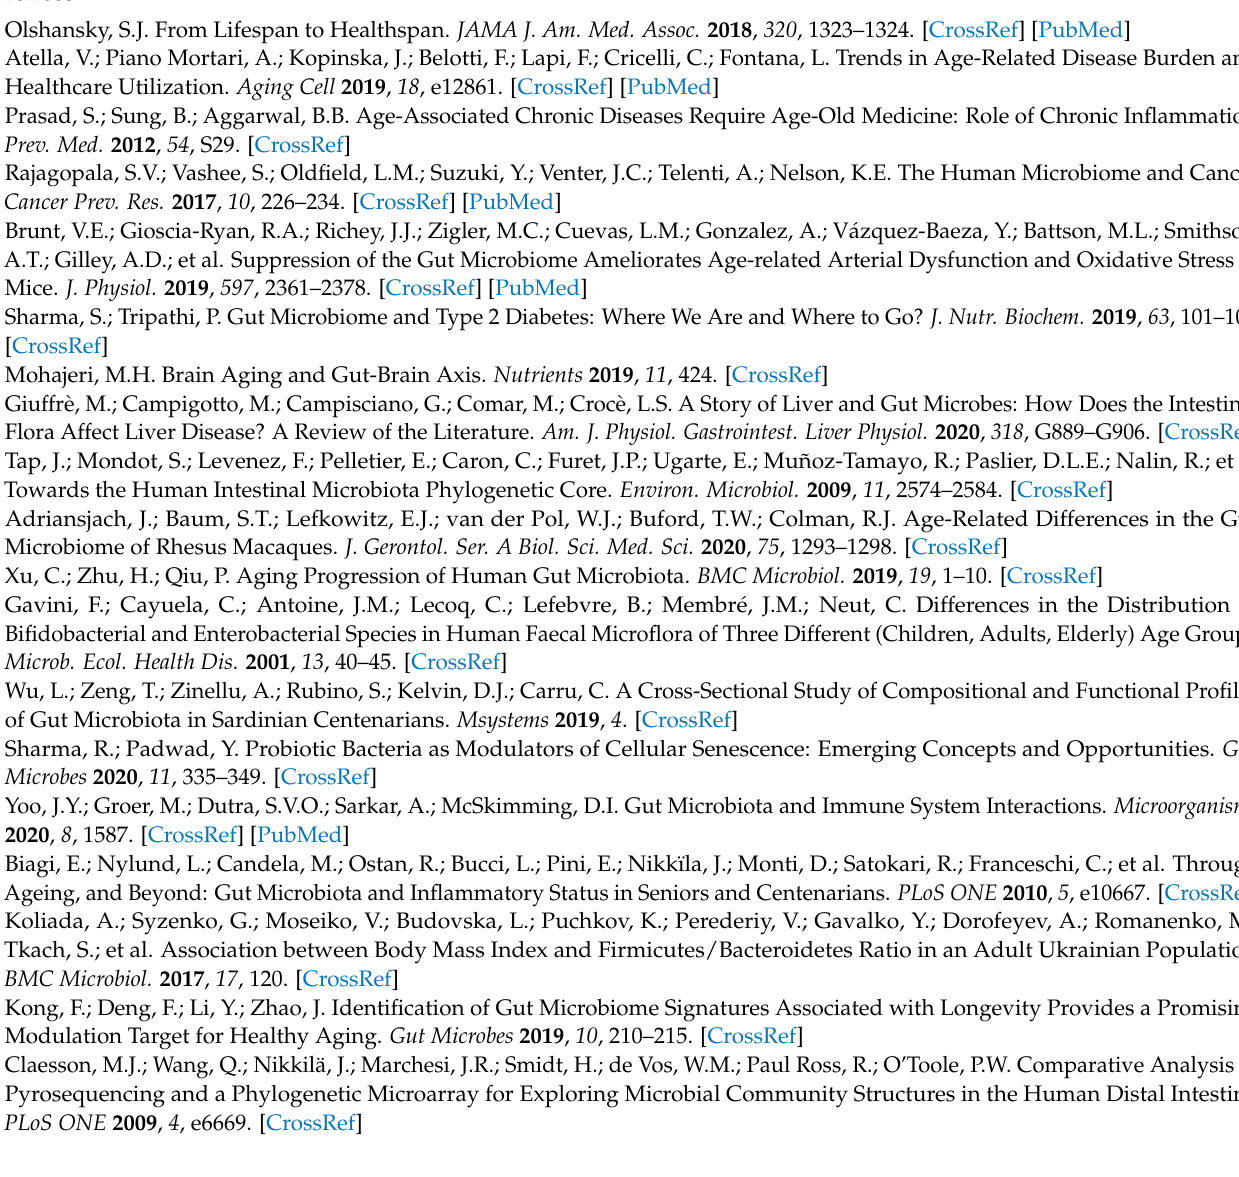
figure preparation, S.D.; supervision, K.E.S.; project administration, K.E.S. All authors have read and agreed to the published version of the